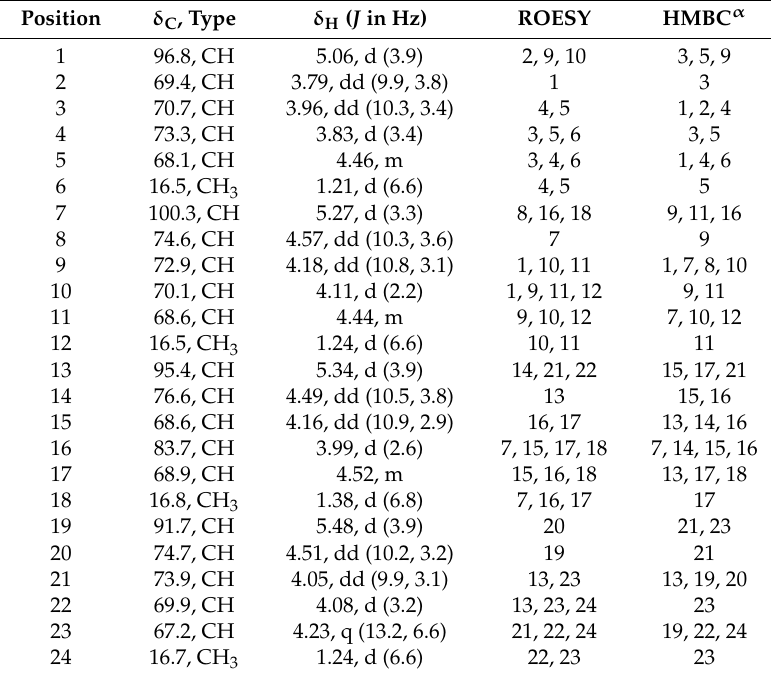
Table 2. Nuclear Magnetic Resonance spectroscopic data (500 Hz, D 2 O) for tetrasaccharide 4F2S(3S) (the product of action of SWF1 on 4F2S(4S)